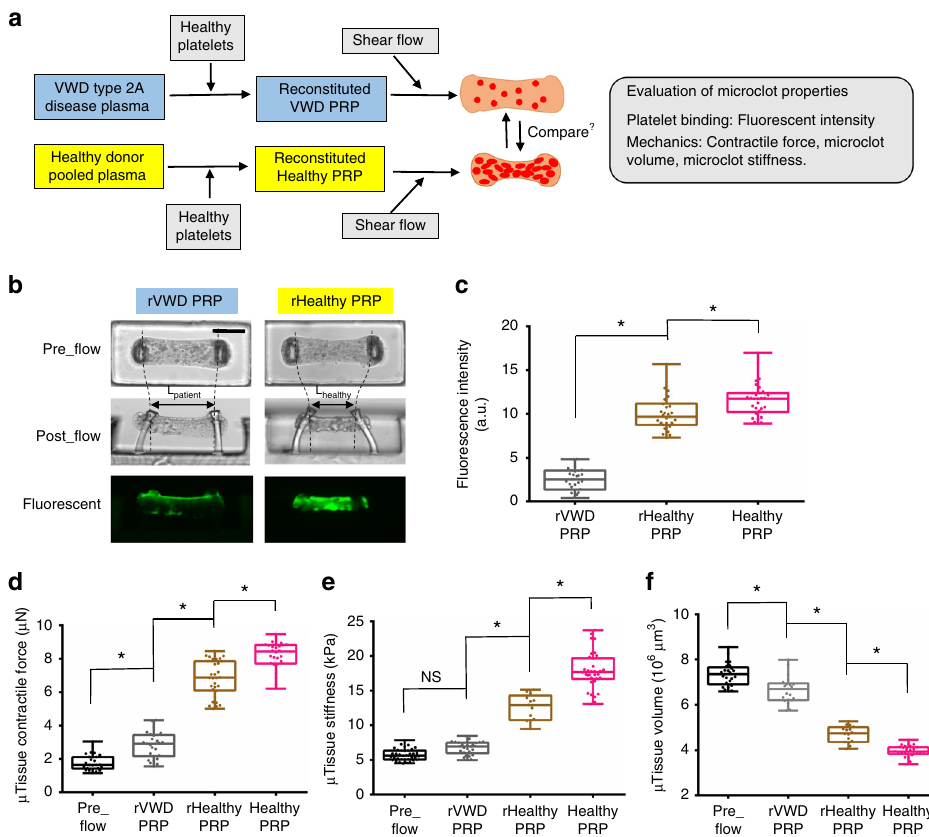
Fig. 5 VWD patient sample results in mechanically weak microclots. a Overview of the strategy for comparing microclot mechanics between VWD sample and healthy donor sample. Healthy human washed platelets were added to VWD patient plasma and healthy donor plasma to form reconstituted VWD PRP (rVWD PRP) and reconstituted healthy PRP (rHealthy PRP). The mechanical properties of microclots formed using these reconstituted systems was compared with “ Healthy PRP ” , normal PRP isolated from healthy volunteer. b Phase contrast and fl uorescence images of microclots formed using VWD patient sample and healthy donor sample. Measured fl uorescence intensity ( c ), contractile force ( d ), stiffness ( e ) and volume ( f ) of the above two microclot groups. * P < 0.05, n > 10, each dot in box plot represents an independent experiment. All box plots with whiskers represent the data